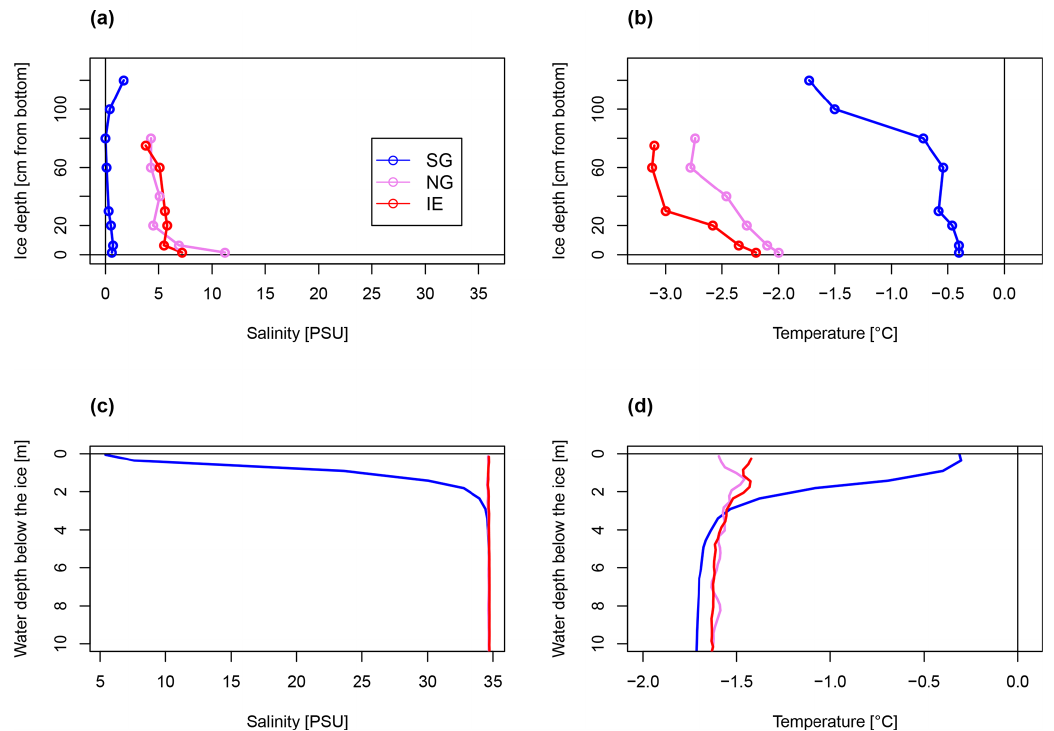
Figure 2. Bulk salinity and temperature profiles in (a, b) sea ice cores (0cm at the bottom) and (c, d) the water column down to 10m below the sea ice, of the three stations.